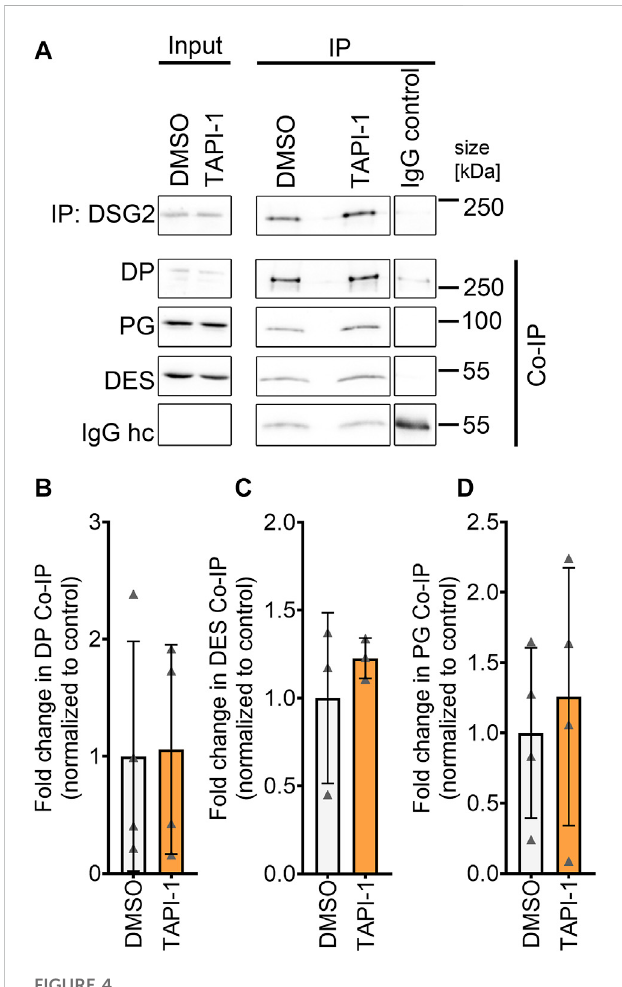
FIGURE 4 No change in desmosomal complex upon inhibition of ADAM17 by TAPI-1. (A) Representative Western blots for immunoprecipitation of DSG2 with quanti fi cation of co-immunoprecipitation (normalized to DSG2pulldown)of (B) DP, (C) DES and (D) PG.IgGheavy chain(IgG hc)servedasloadingcontrolforimmunoprecipitatedsamples,* p ≤ 0.05, unpaired Student ’ s t -test, N = 4 biological